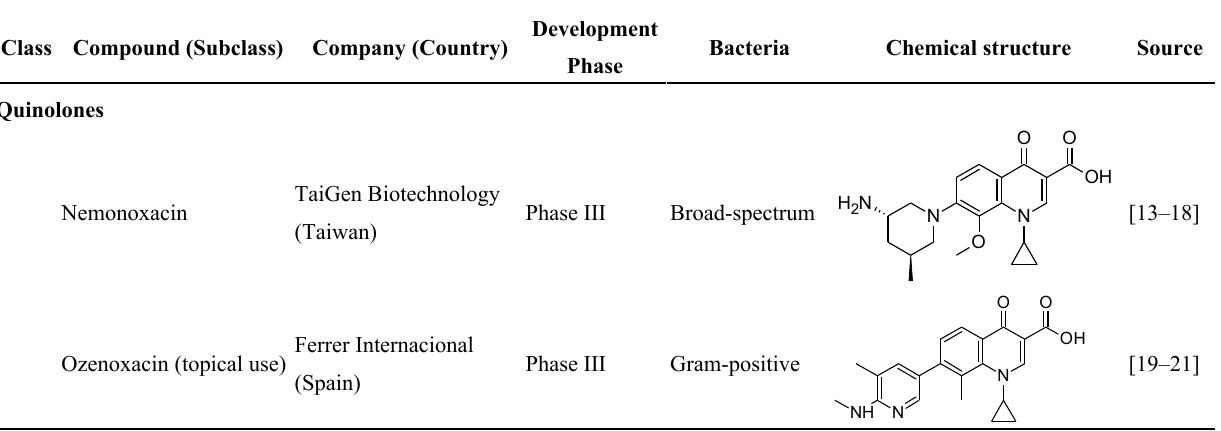
Table 1. Pipeline of antibiotics in known chemical